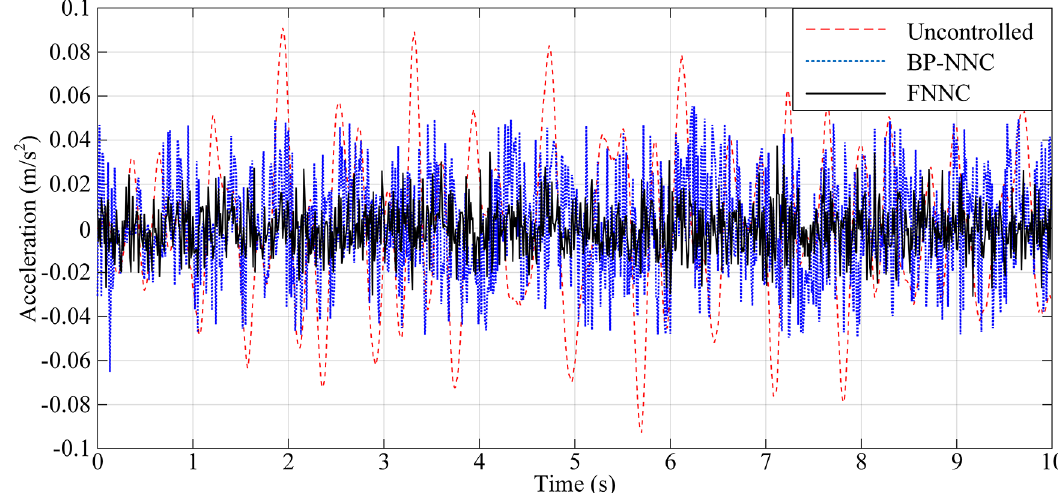
Fig. 20. Time-domain response of horizontal vibration acceleration of the elevator car with a medium